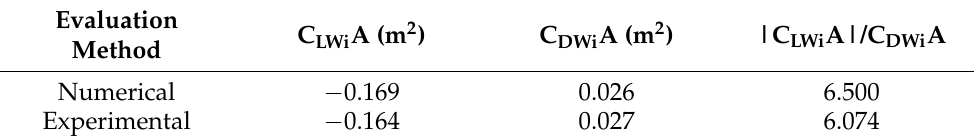
Table 1. A table showing the lift and drag areas as well as the efficiency values obtained under the two evaluation